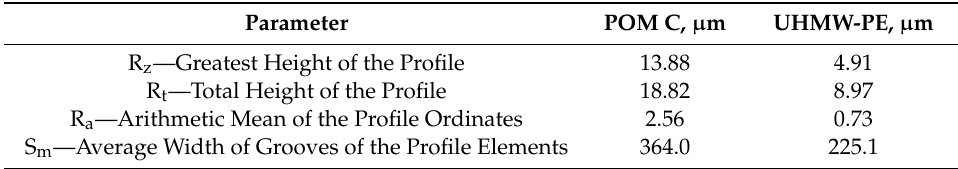
Table 2. Results of sample surface roughness measurements.